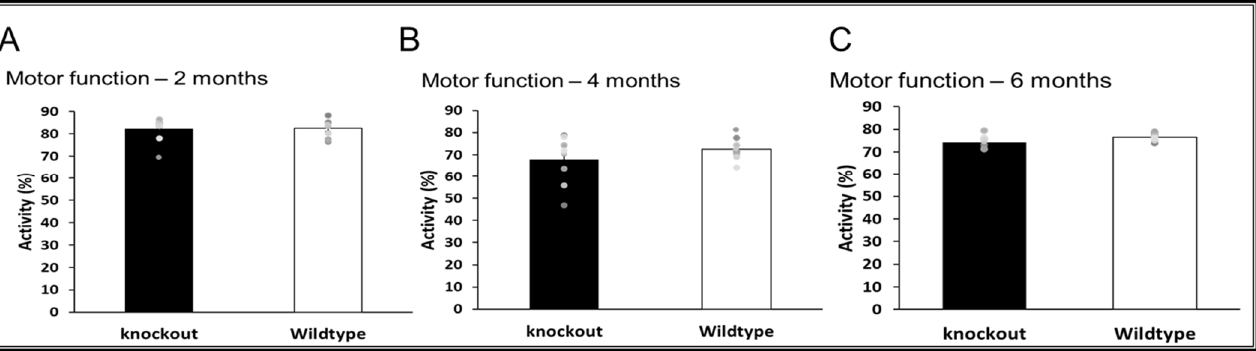
Figure 7 . The effect of CD24 knockout on motor function. Abolition of CD24 did not effect motor function at 2 months (A), 4 months (B) and 6 months (C). n = 8 mice per group